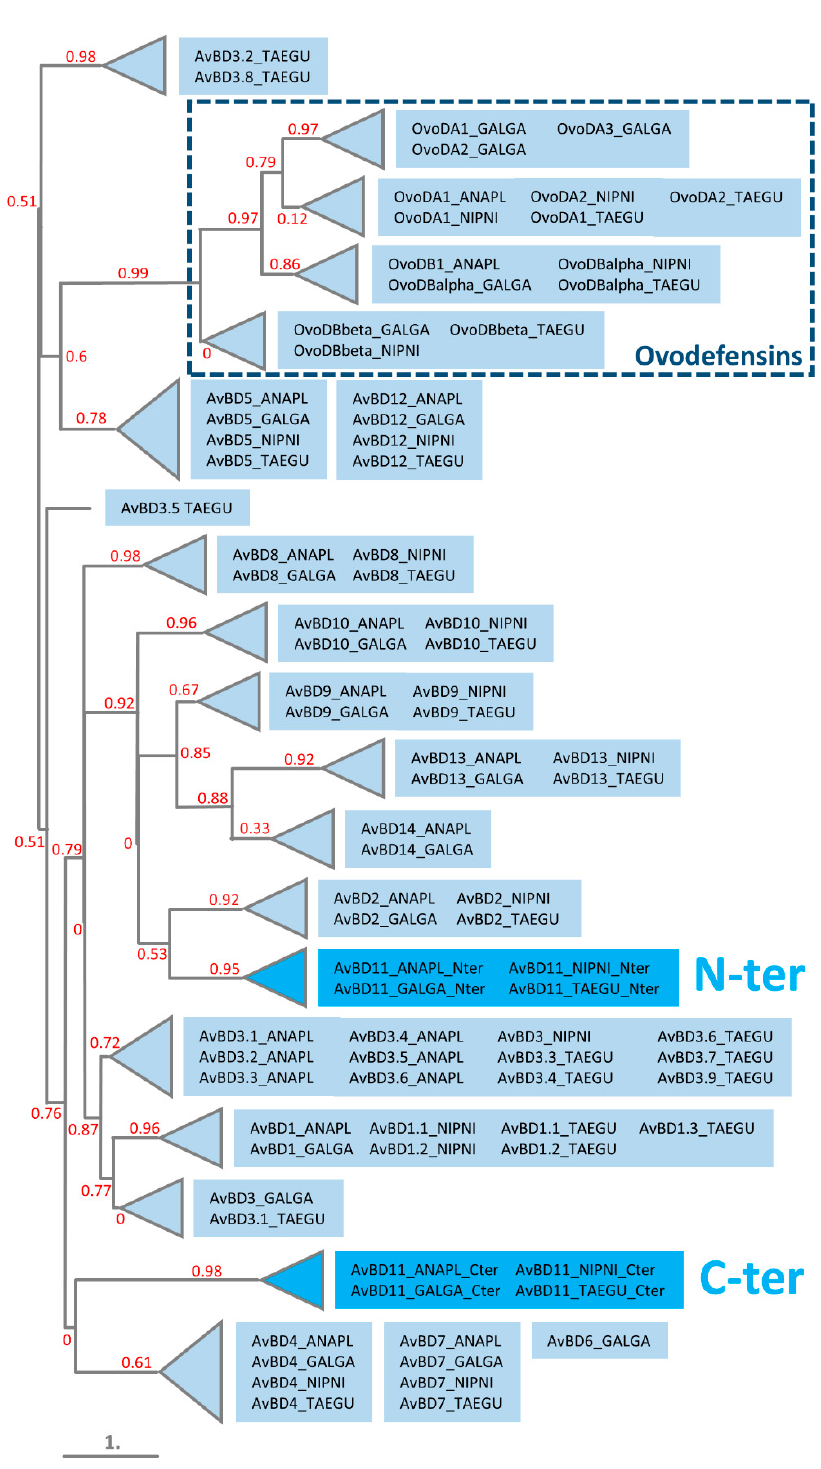
Figure 4. Phylogenetic relationships of the N-terminal (N-ter) and C-terminal (C-ter) domains of AvBD11 with monodomain AvBDs and OvoDs in four distant birds (duck, chicken, crested ibis, zebra finch). The phylogenetic tree was constructed using the maximum-likelihood-based program PhyML from MAFFT-based alignments adjusted to the length of N-ter and C-ter AvBD11. Branch support values are indicated in red. ANAPL, Anas platyrhynchos (duck); GALGA, Gallus gallus (chicken); NIPNI, Nipponia nippon (crested ibis); and TAEGU, Taeniopygia guttata (zebra finch).